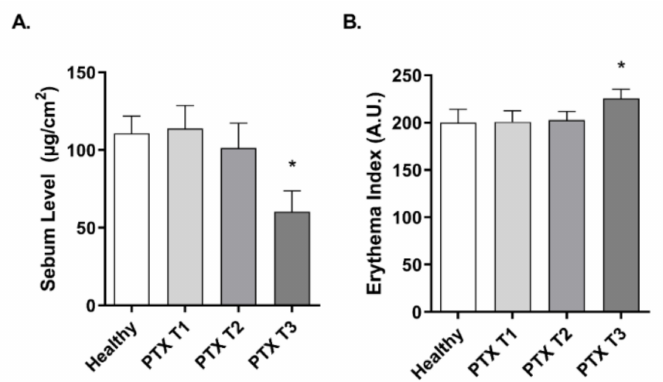
Figure 3. Paclitaxel reduces sebum levels and increases erythema in oncologic patients. ( A ) Sebum levels were measured in 20 oncologic patients before (T1), during (T2), and after (T3) treatment with PTX, and in 20 healthy subjects as a control group. Sebumeter SM 815 ® was used to obtain the forehead sebum value. ( B ) The erythema index was measured in 20 oncologic patients before (T1), during (T2), and after treatment (T3) with PTX, and in 20 healthy subjects as a control